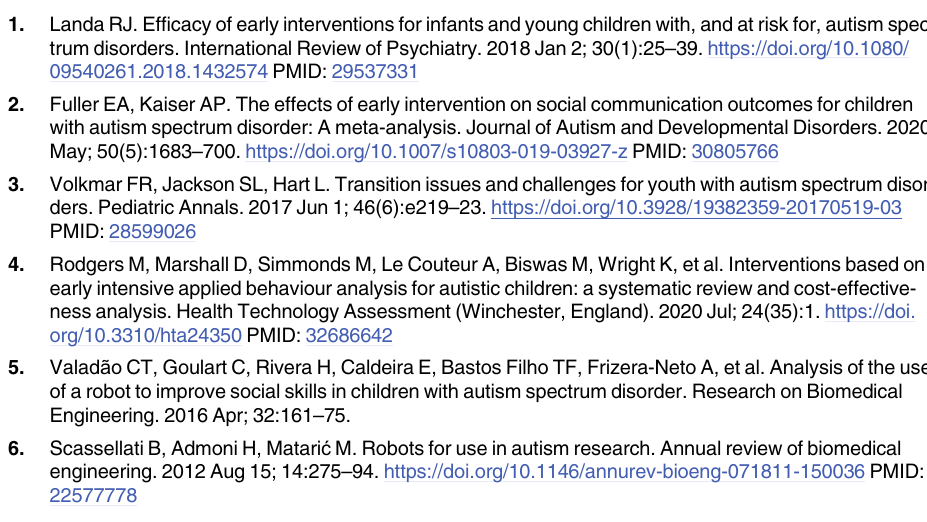
S1 Table. PRISMA 2020 checklist. S2 Table. Search terms per bibliographic database. S3 Table. Quality assessment for included studies. S4 Table. Individual study quality assessment overview. S5 Table. Vote count outcomes by